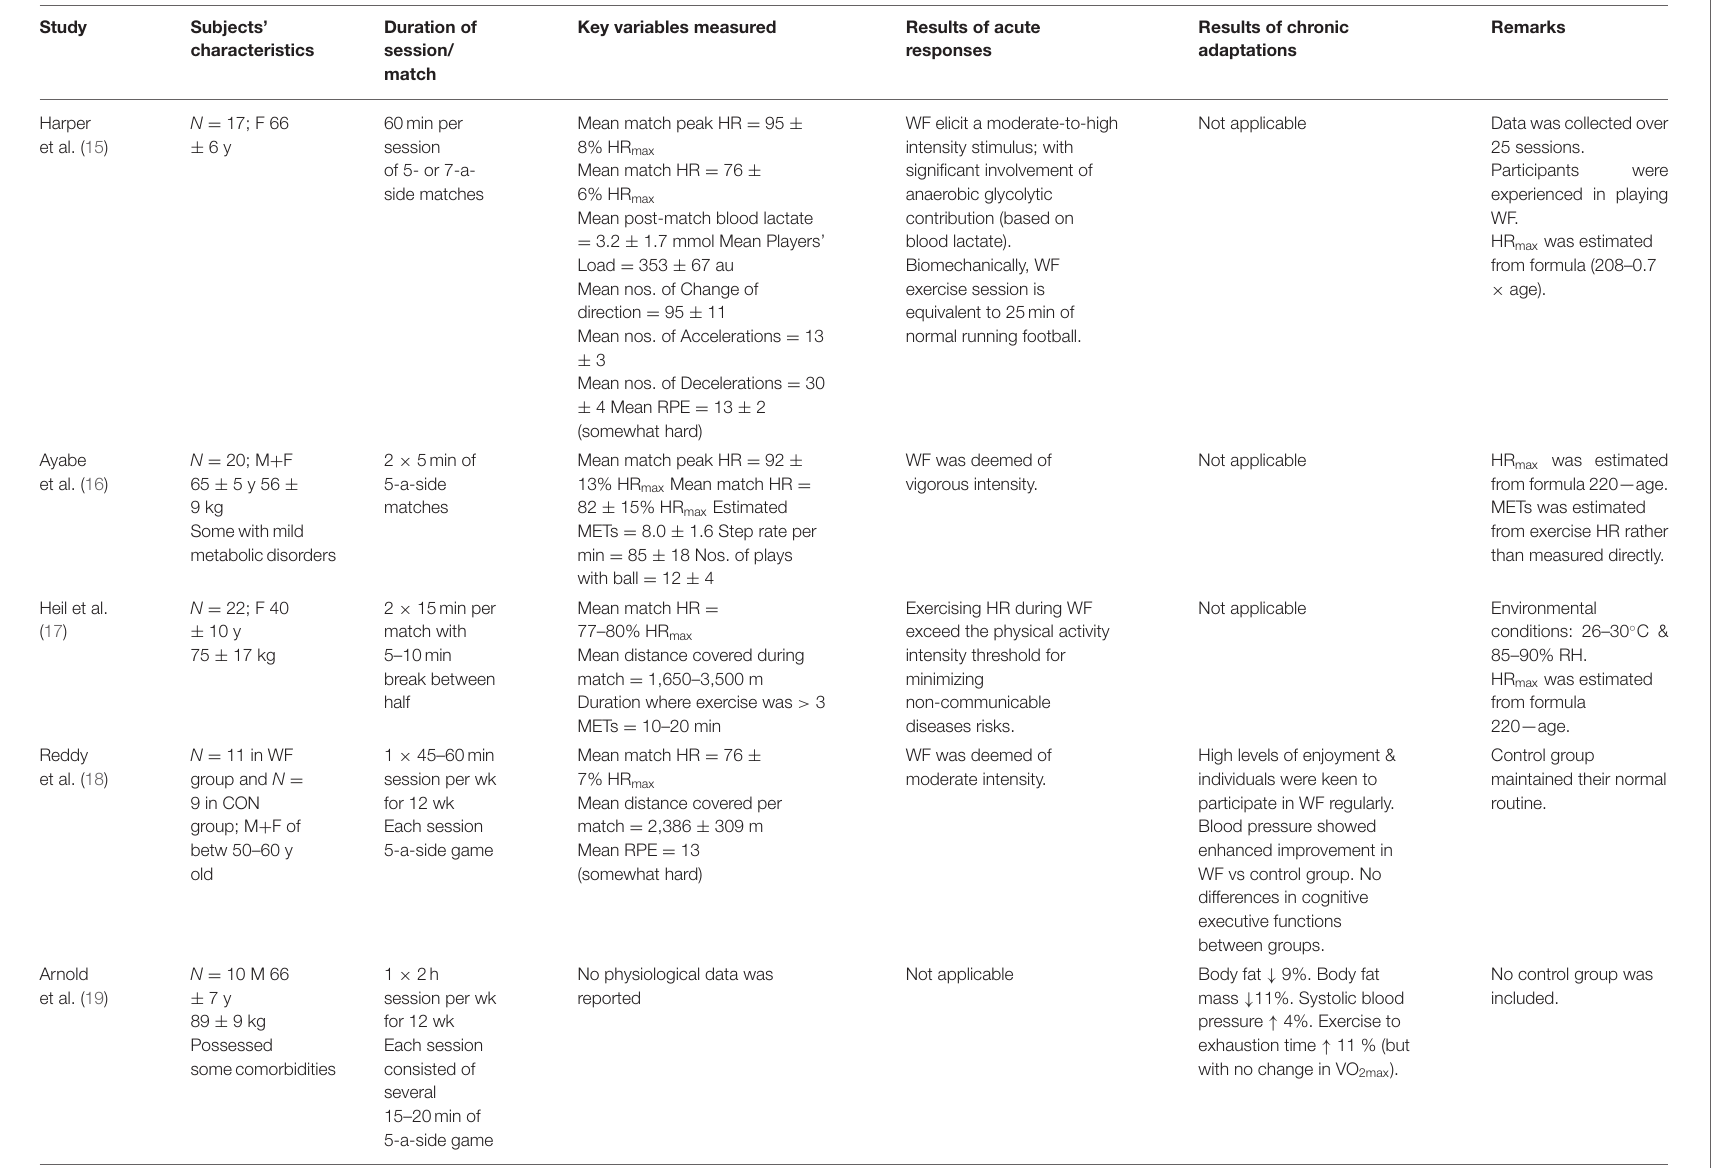
TABLE 1 | Acute responses and chronic adaptations of studies on walking